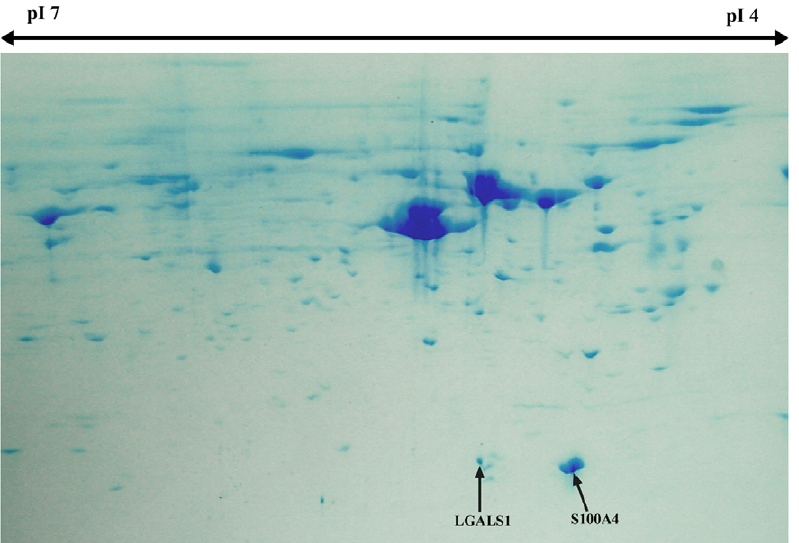
Figure 2. Two dimensional electrophoresis gel for AP cells. The gel highlights the strong expression of S100A4 and LGALS1 proteins in AP cells. AP cells, antlerogenic periosteum cells.